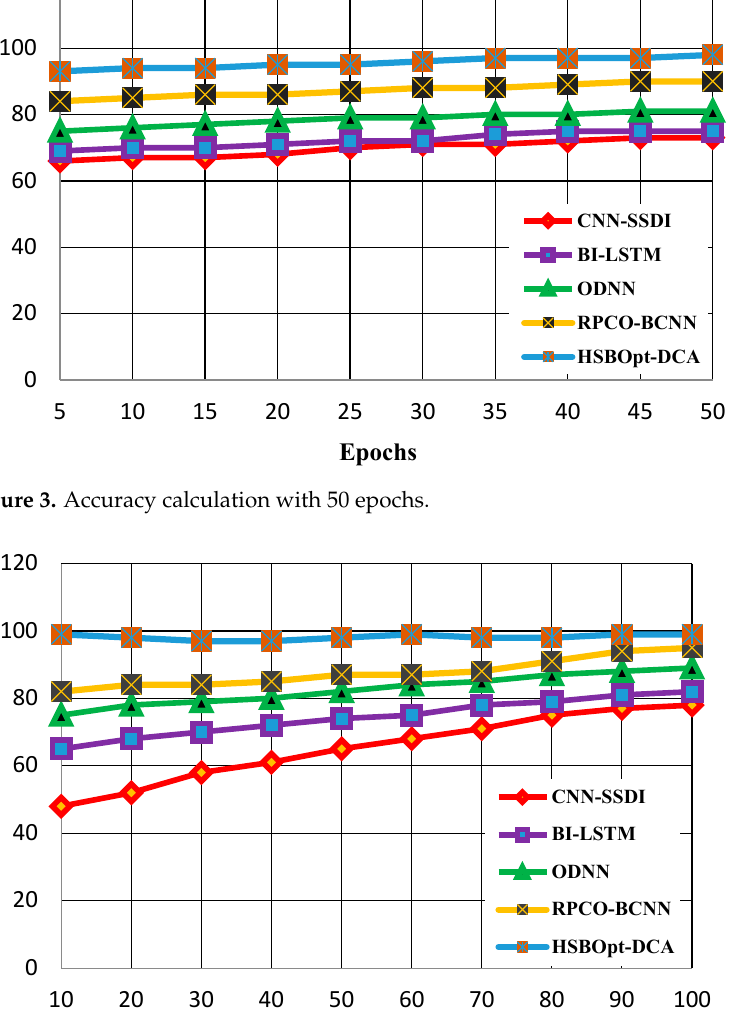
Figure 3. Accuracy calculation with 50 epochs.